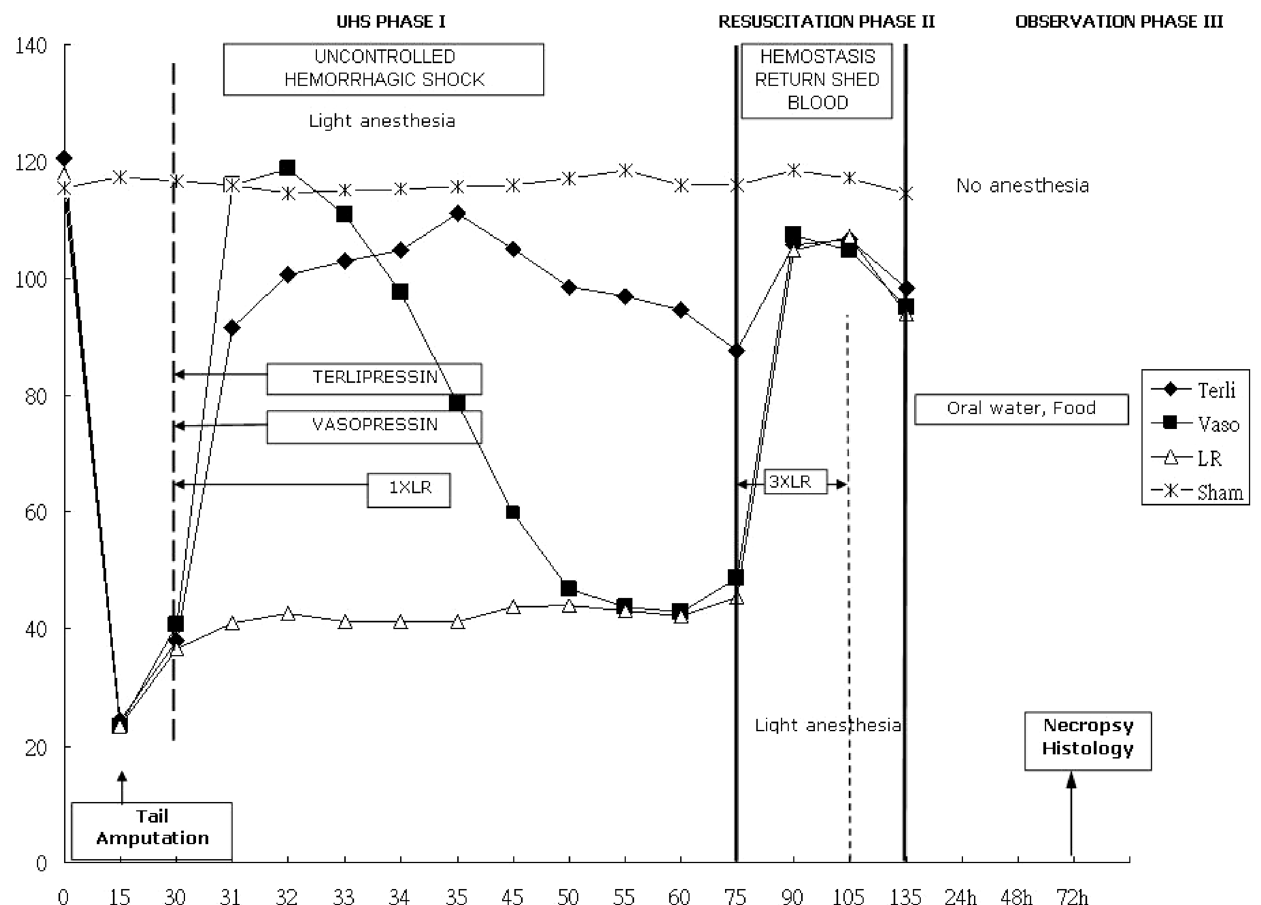
Figure 1. Experimental protocol and mean arterial pressure over time in four treatment groups. The MAP for the sham group is around 110 mmHg.